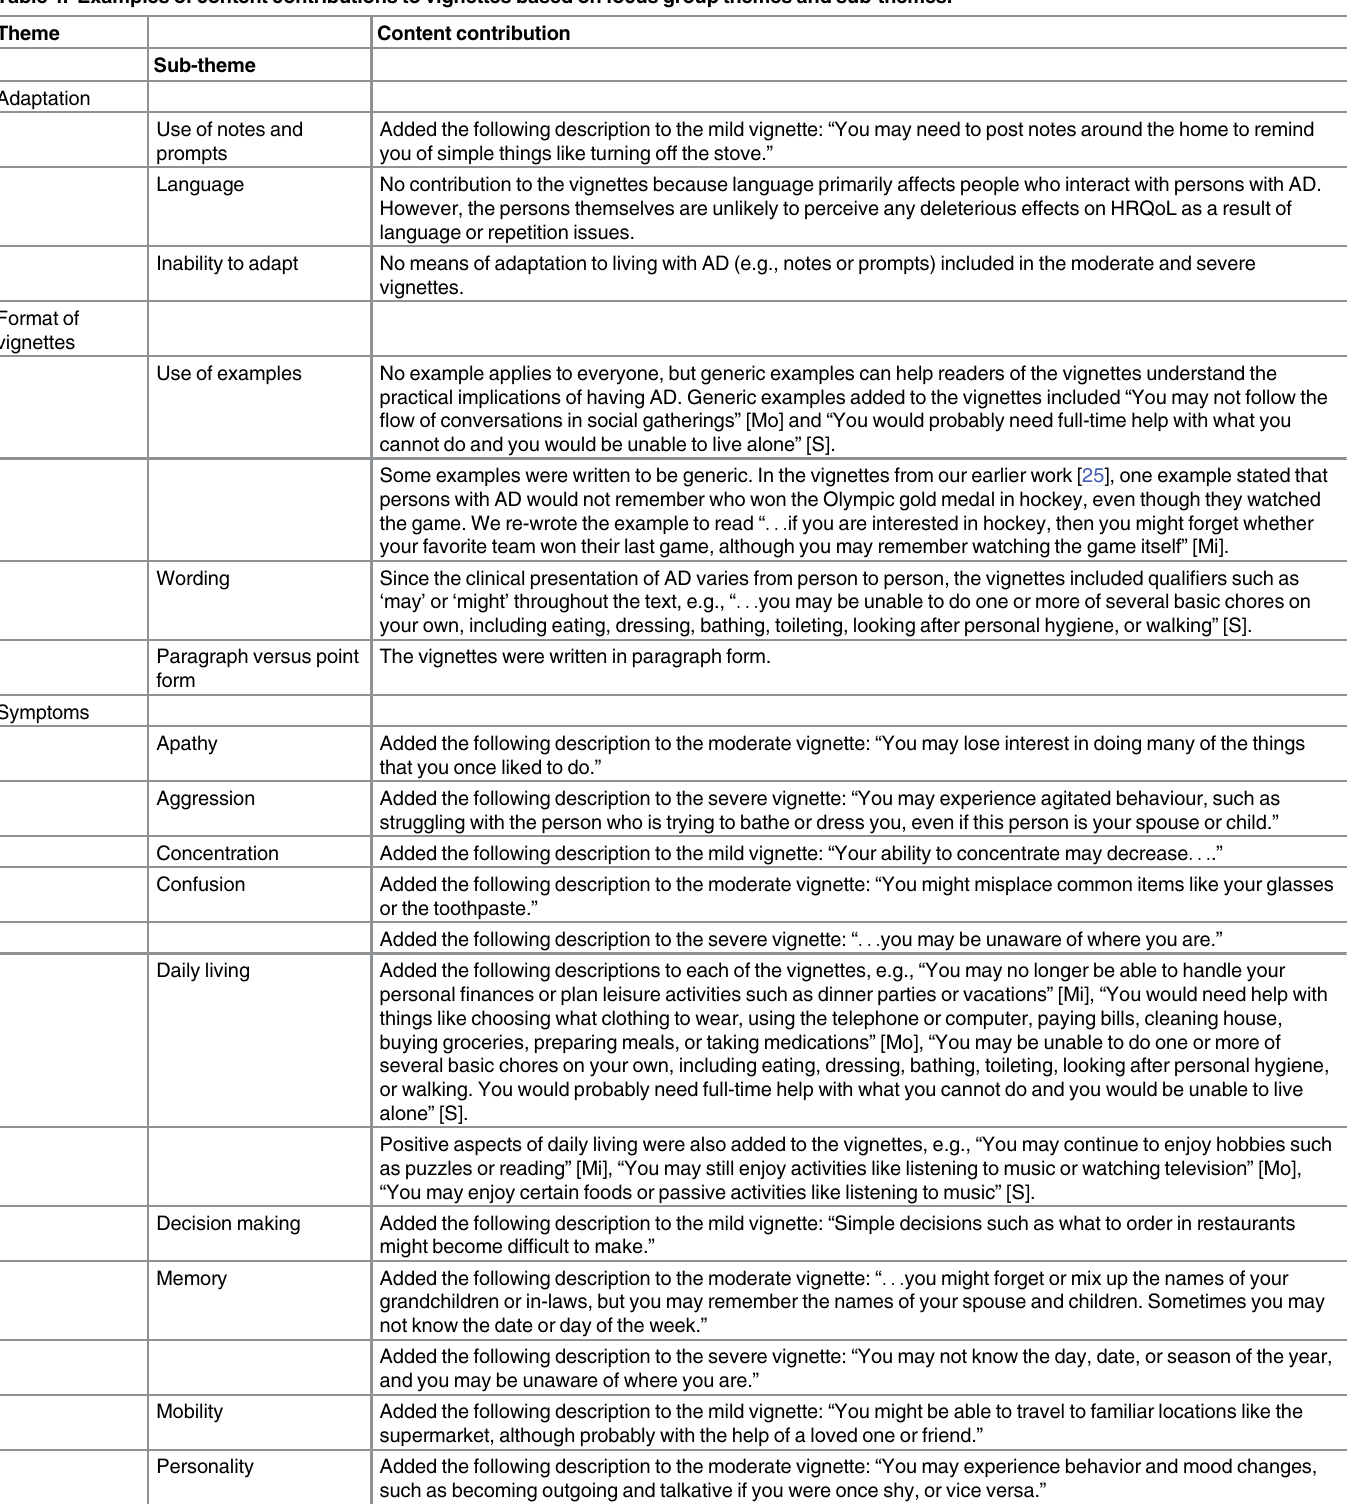
Table 4. Examples of content contributions to vignettes based on focus group themes and